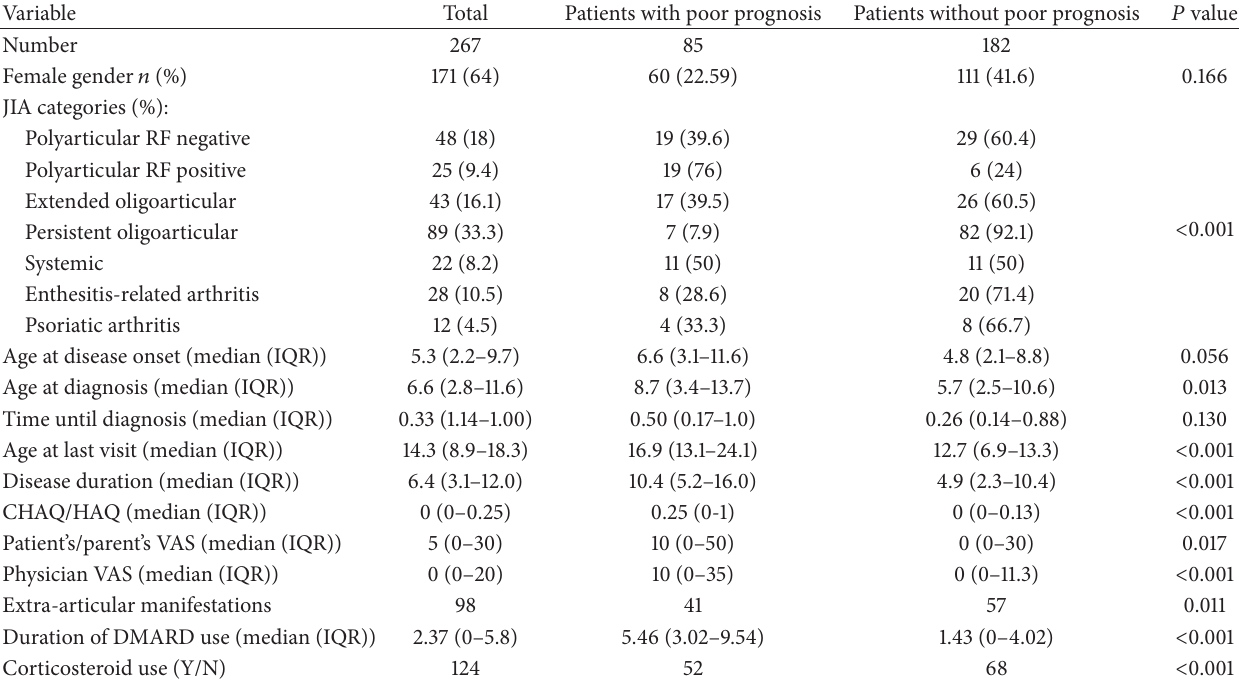
Table 1: Distribution of the clinical characteristics of patients with and without poor